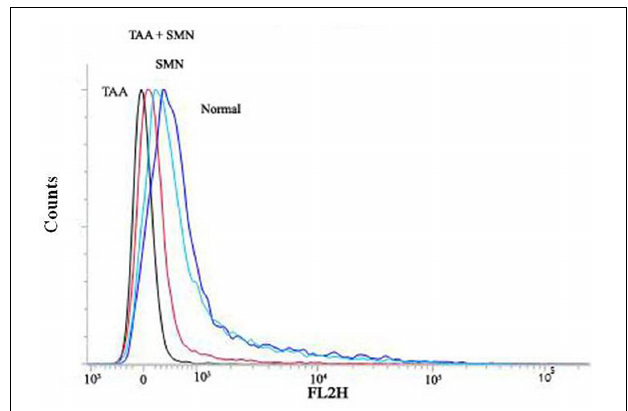
FIGURE 7 | Measurement of the mitochondrial membrane potential by flow cytometry analysis (using JC-1) from liver tissue homogenates.